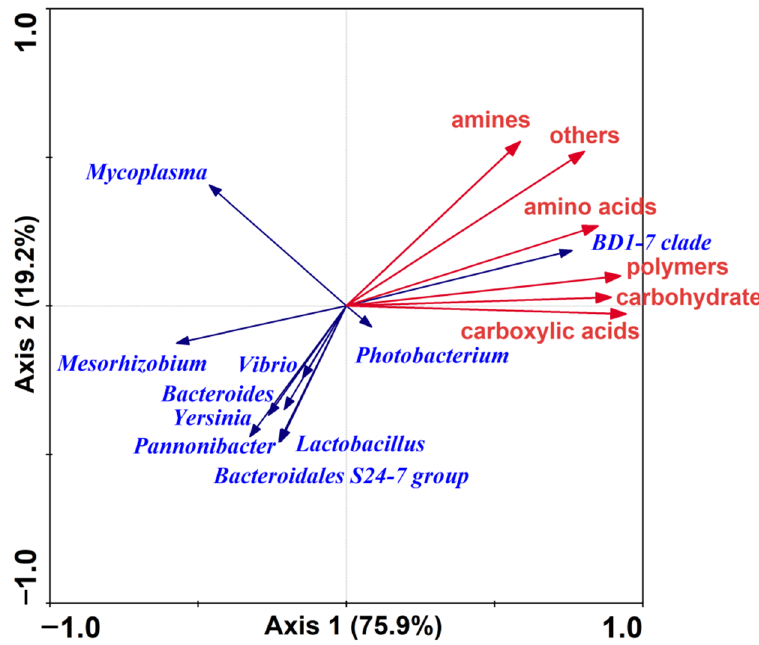
Figure 10. Redundancy analysis ordination of